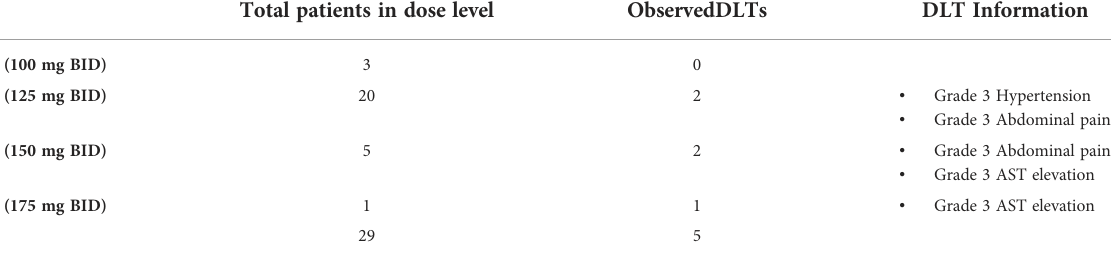
TABLE 3 Dose Limiting Toxicities by Dose